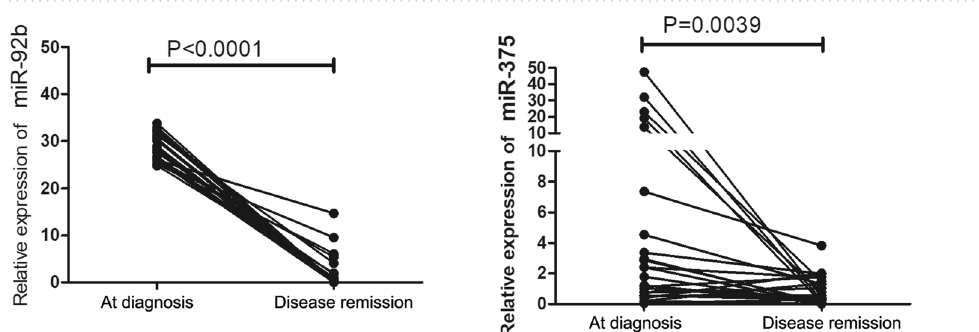
Figure 4. Circulating miRNA levels during chemotherapy. Plasma levels of miR-92b and miR-375 at diagnosis and disease